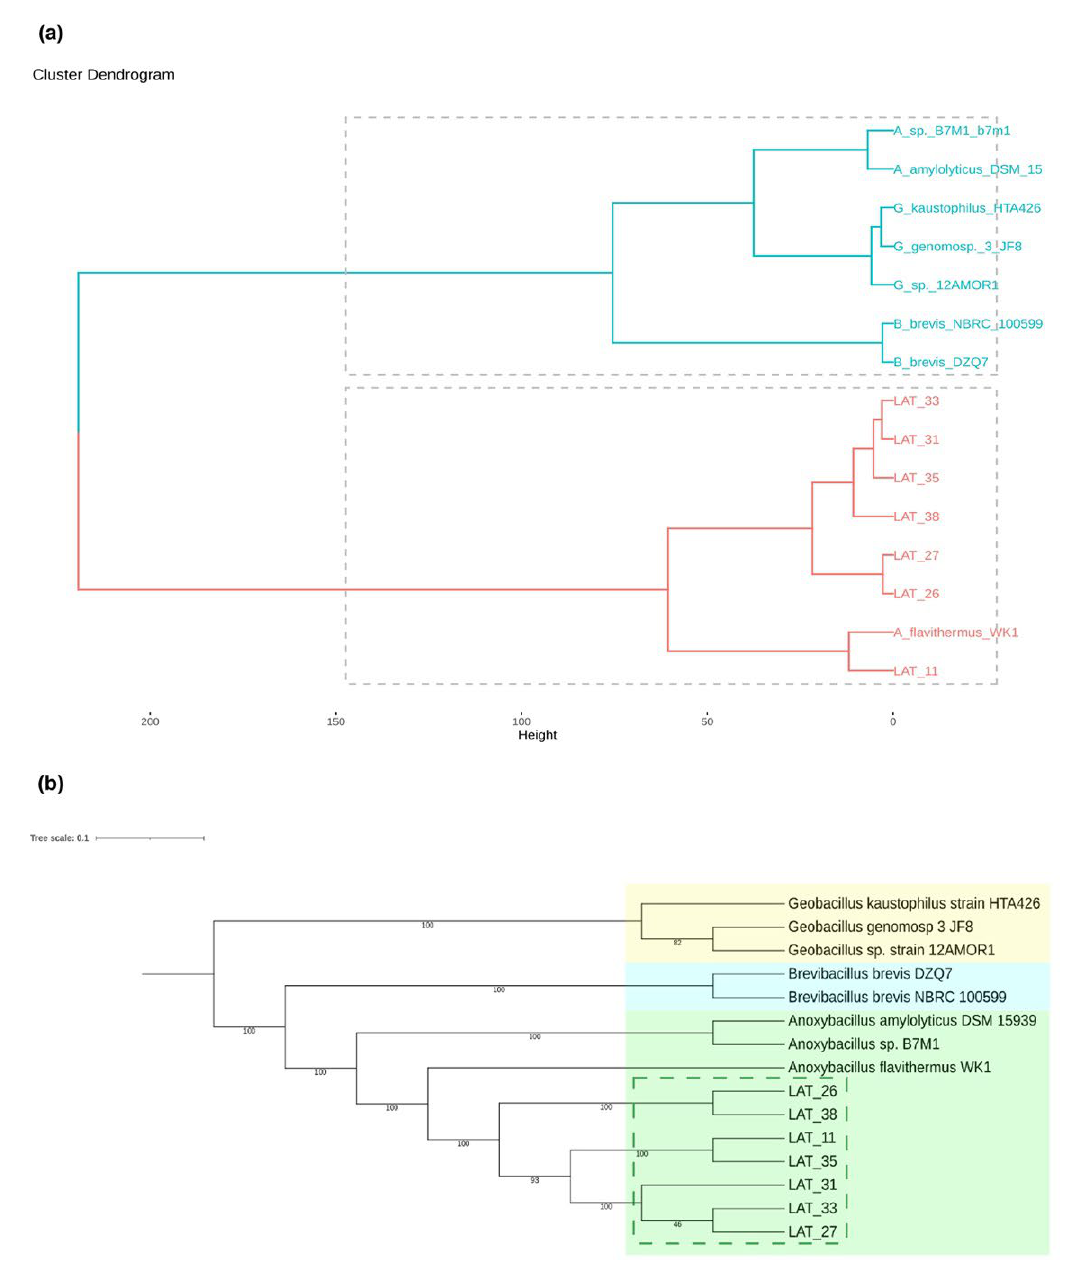
Figure 2. ( a ) Global similarity phylogenomic tree (based on ANIb and TETRA results) consisting of Brevibacillus (B_), Geobacillus (G_), Anoxybacillus (A_), and our genomes (LAT_11, LAT_26, LAT_27, LAT_31, LAT_33, LAT_35, and LAT_38). The colors distinguish the two main clades. ( b ) Phyloge- nomic tree (maximum likelihood estimation); the tree is colored by genus: yellow represents the genus Geobacillus , blue represents Brevibacillus , and green represents Anoxybacillus . Clusters with dotted lines correspond to the Antarctic Anoxybacillus strains isolated in the present study.